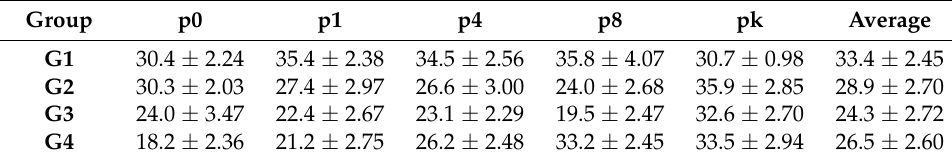
Table 1. Average and standard deviation ( ± SD) of cell count with positive NF- κ B expression of each group in each position (p). Distances in mm from the performed bone lesion (p0 = local of